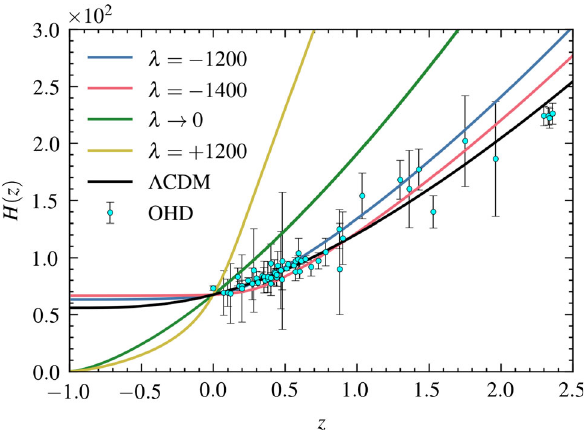
Fig. 3 Deceleration parameter ( q ) as a function of redshift ( z ) for dif- ferent values of λ for standard Rényi HDE model (with (cid:12) m 0 = 0 . 315 and H 0 = 67 . 4 km/s/Mpc